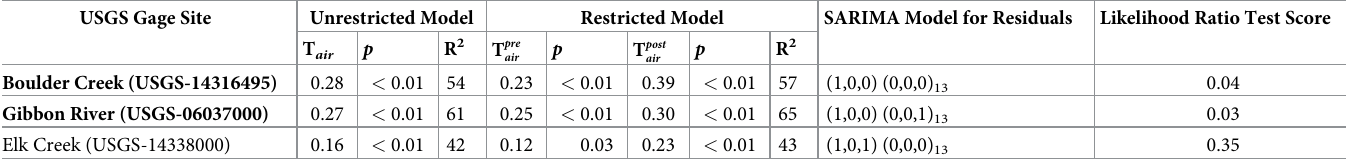
Table 3. Coefficients and fitness of restricted and unrestricted regression models for pre- and post-fire weekly winter air temperature—water temperature relations for studied stream sites. Sites in bold are those where the restricted regression model was significantly ( p < 0.05) different from the unrestricted regression model.